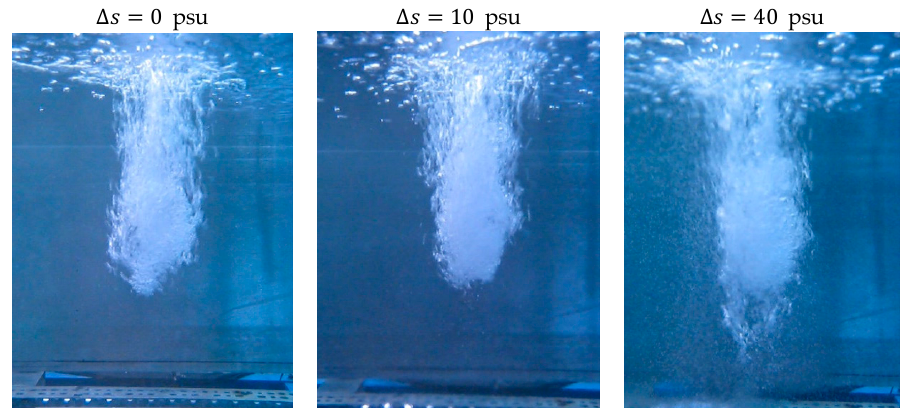
Figure 3. Lab observations of bubble penetration depth and qualitative plume-bubble interactions with L j = 30 cm (from left to right, ∆ s = 0, 10, 40 psu). The penetration depth and width of the bubble plume were determined using image processing as follows. Each image of an experimental run was split into 3 separate images, each comprised of the red, green, and blue pixel intensities. MATLAB was used to apply an image filter that uses the Sobel operator to create a new image that exaggerates the edges present in each of the 3 images. The pixel intensities for each row of pixels were scanned from left to right, in the portion of the image that the plume is located (i.e., ignoring any bottom features as well as the bubbles on the water surface). Prior to each experimental run, an image of a ruler placed in the plane of the bubble plume centerline was taken in order to determine the conversion of image pixels to centimeters without the effect of parallax. The widest extent of the image edges (predominantly using the green image) was taken as (cid:1849) , the width of the bubble plume. The deepest extent of the image edge was taken as the bubble penetration depth (cid:1834) (cid:3043) . See Figure 4 for an example of bubble plume width determination. Experimental results for the penetration depth are shown in Table 2.